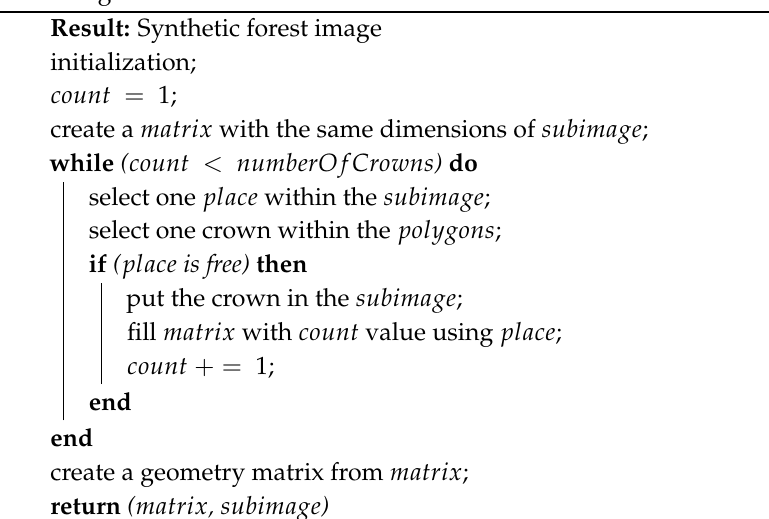
Algorithm 1: Algorithm for building a a synthetic forest image to compose the training